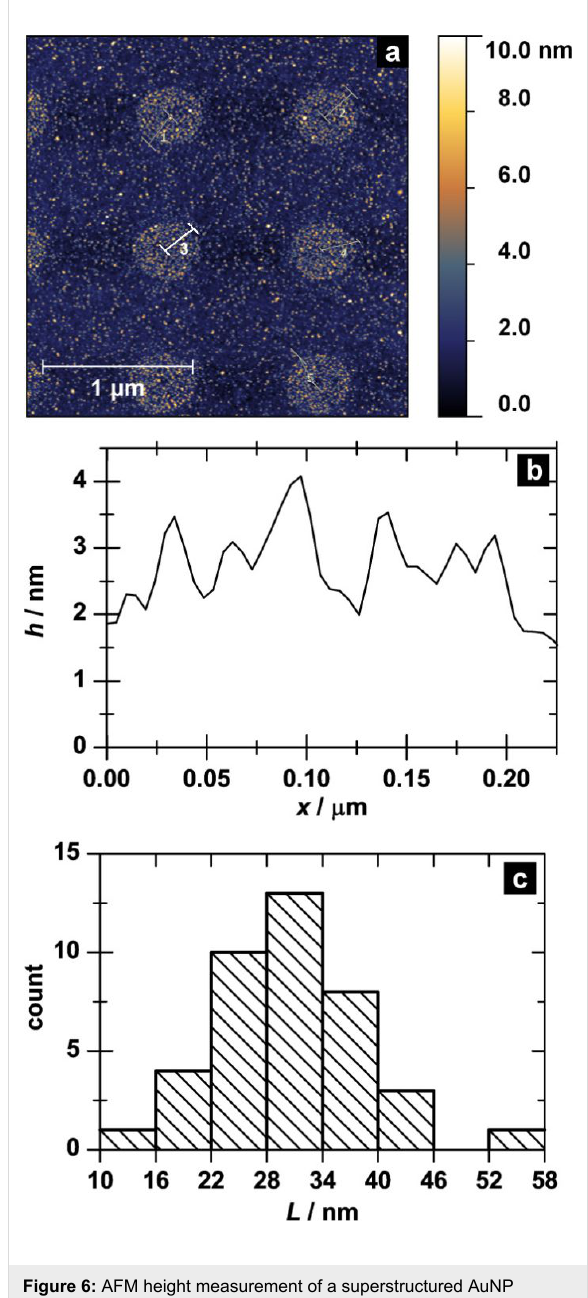
Figure 6: AFM height measurement of a superstructured AuNP pattern (a), exemplary height profile (b) of line 3 in (a), and histogram of the determined peak-to-peak distances in all measured height profiles